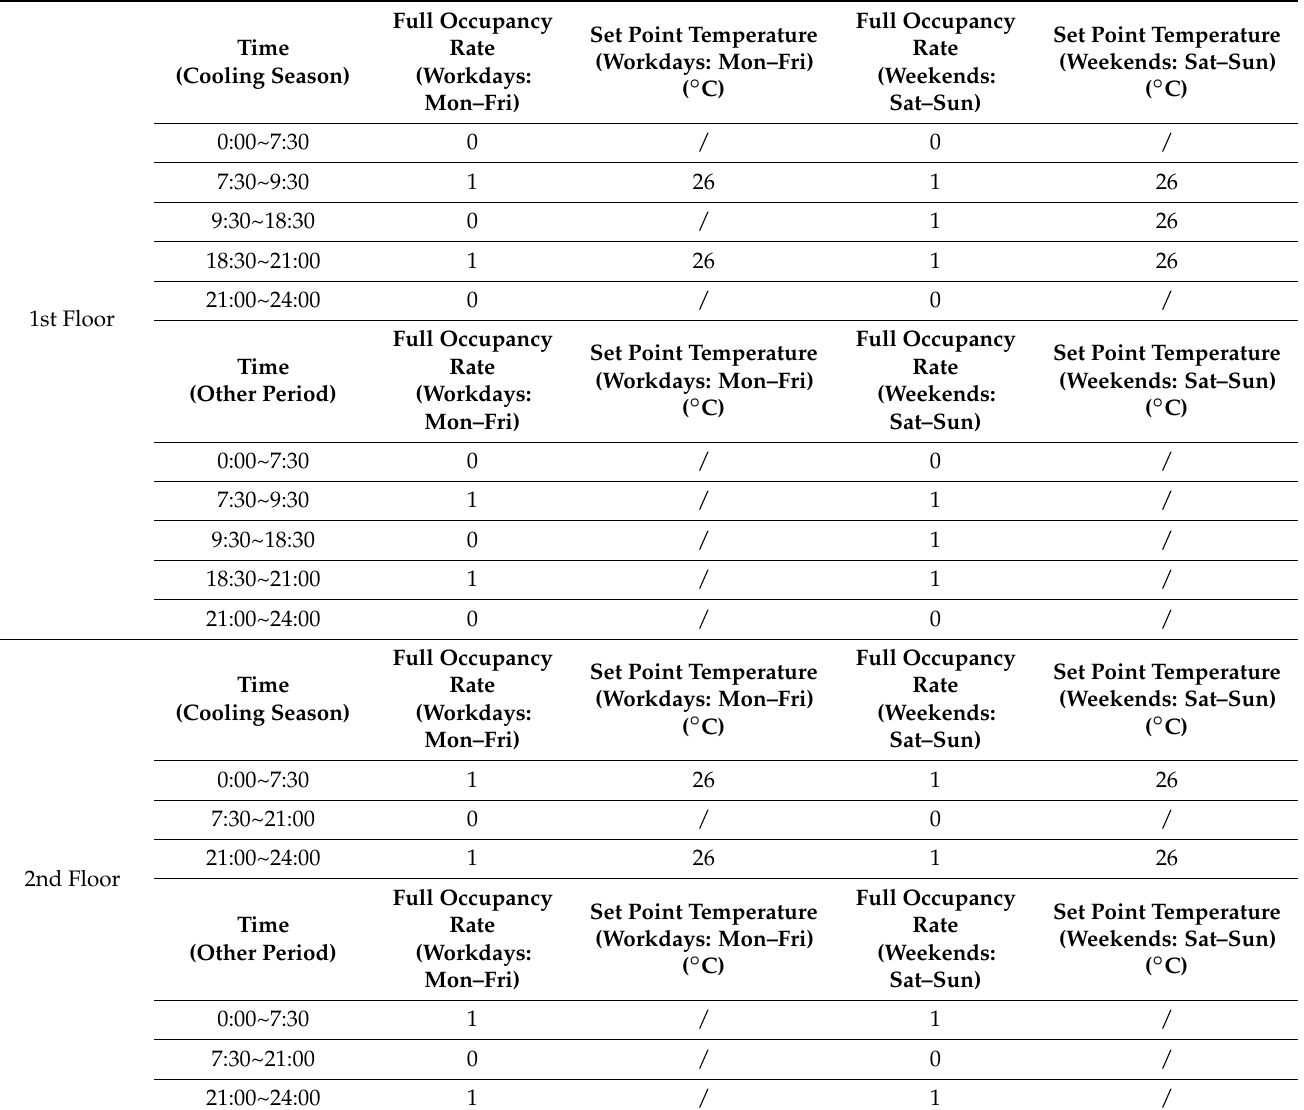
Table 4. HVAC Schedule, Set Point Temperatures and Full Occupancy Rates Configurations through- out the testing year (adapted from [33]).